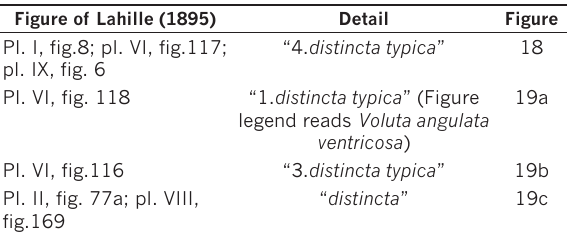
Table 6. Voluta angulata distincta , specimens figured by La - hille (1895) with the detail of the inscriptions in their shells and figures here.